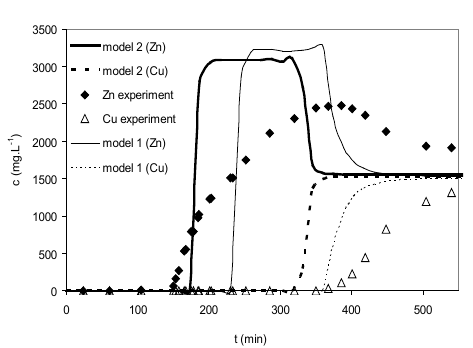
Figure 6. Calculated adsorption isotherms of copper for various pH using the model 2